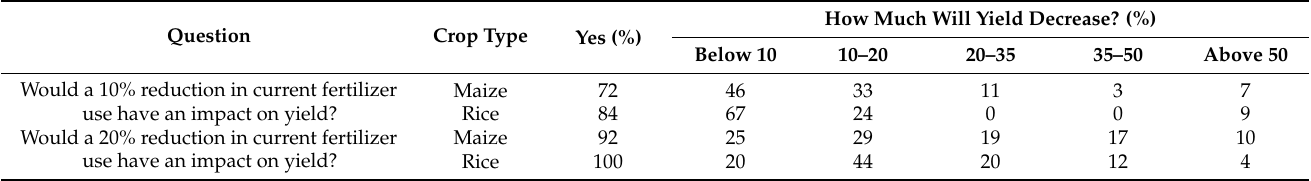
Table 8. Farmers’ perception of the impact of fertilizer reduction on